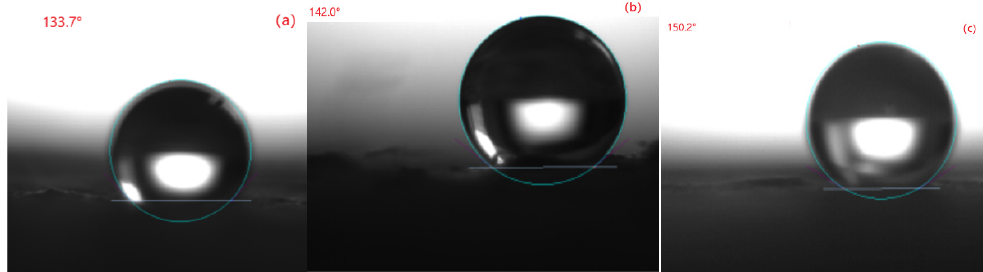
Figure 4. Contact angle of the concrete surface treated by SiO 2 sol and silane emulsion: ( a ) S1; ( b ) S2; ( c ) S3.